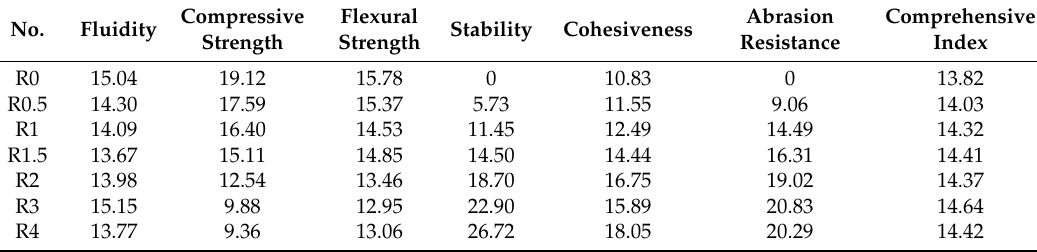
Table 9. Dimensionless values of parameters for performance evaluation and the comprehensive